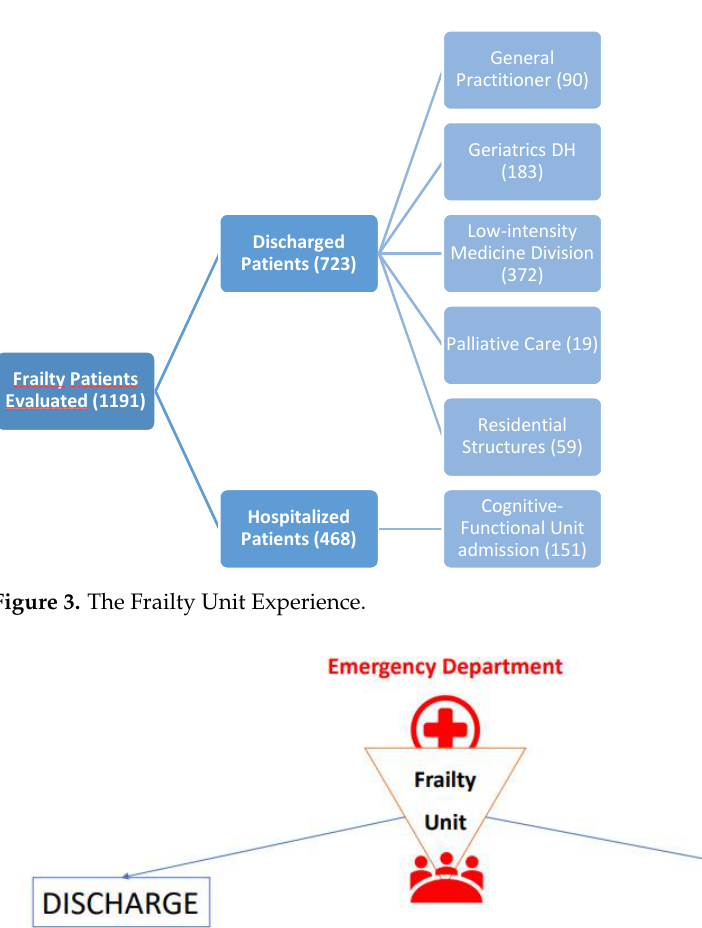
Figure 3. The Frailty Unit Experience.